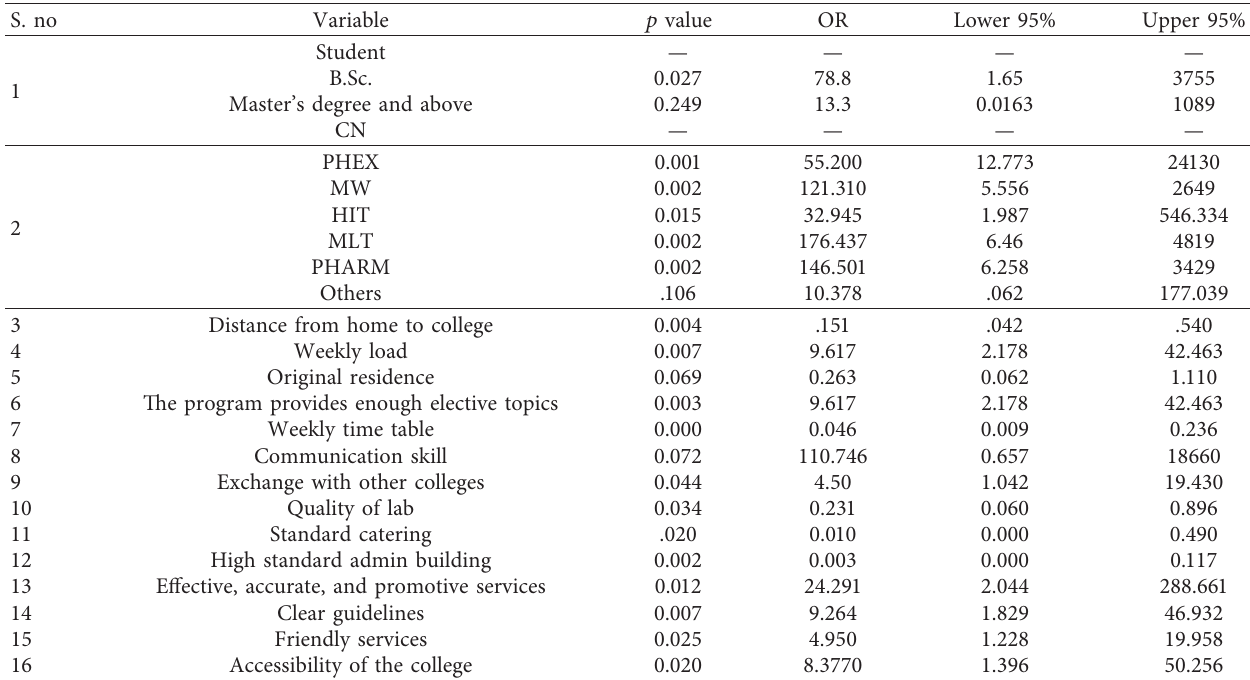
Figure 1: Distribution of educational quality per parameter in Arba Minch College of Health Sciences. Table 3: Distribution of factors associated with the educational quality AMCHS in 2017.